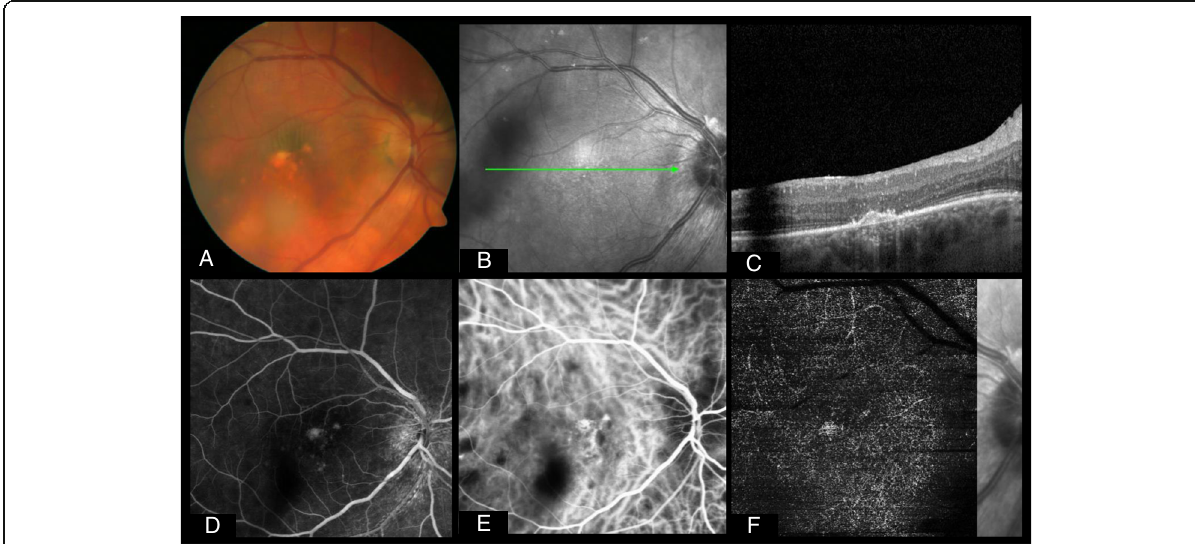
Fig. 1 This patient diagnosed with birdshot retinopathy had been treated with intravitreal steroids abroad due to uveitic macular edema prior to final diagnosis. At first presentation, vision was already decreased to 20/100 on the right eye and 20/200 on the left eye, respectively. On both eyes, there was central atrophy of outer retinal layers besides typical yellow-white lesions on the fundus ( a ) and furthermore persisting macular edema on the left eye (not shown). These pictures reveal the presence of a choroidal neovascularization (CNV) of the right eye, although there was no intraretinal fluid present on the optical coherence tomography (OCT) scan around a suspicious lesion ( b and c ). Fluorescence angiography peak phase shows light hyperfluorescence of this lesion besides smaller hyperfluorescent spots corresponding to small pigment epithelial detachments ( d ). On indocyanine green angiography, the birdshot lesions are typically hypocyanescent, but here, central hypercyanscence can be noted ( e ). OCT angiography confirms a quiescent subretinal (type 1) CNV ( f